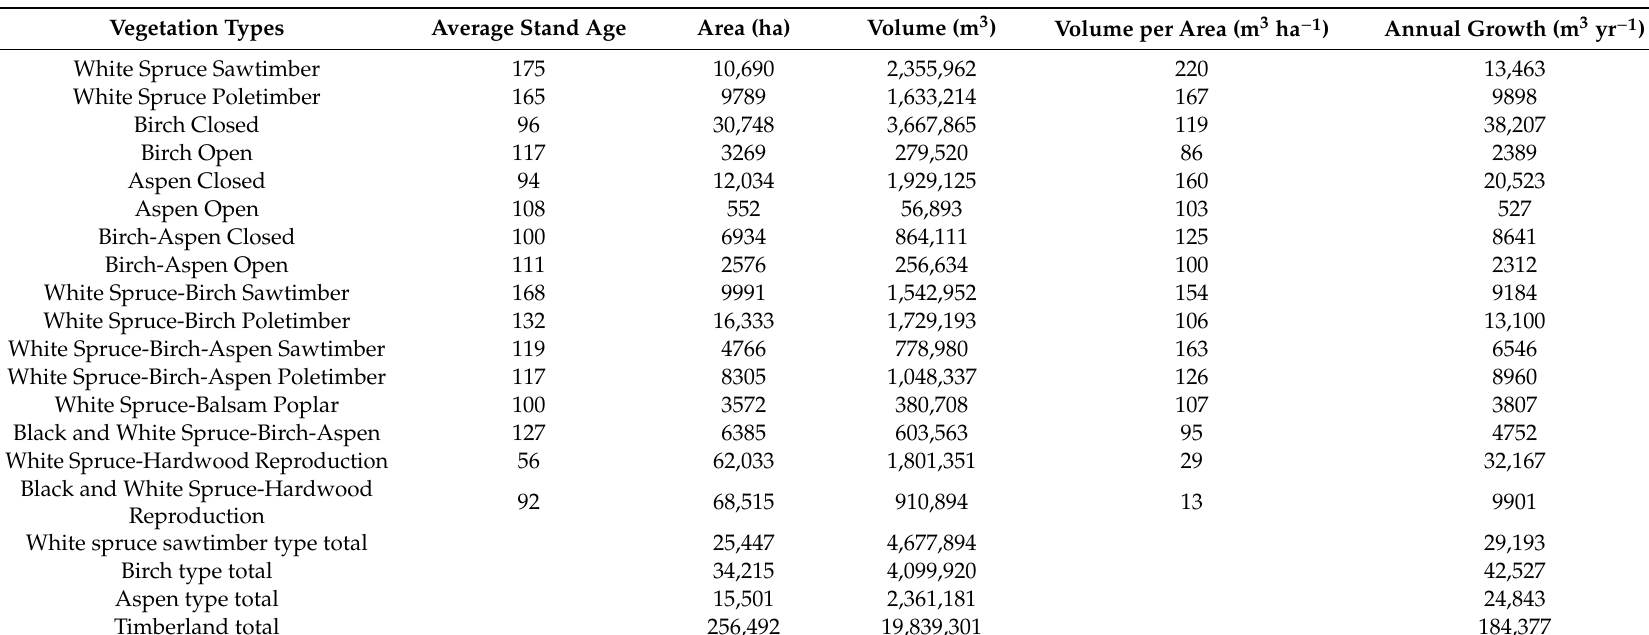
Table 2. Average stand age, area, timber volume, volume per area, average annual growth, and annual growth of each timberland vegetation type on state forest lands (Fairbanks management